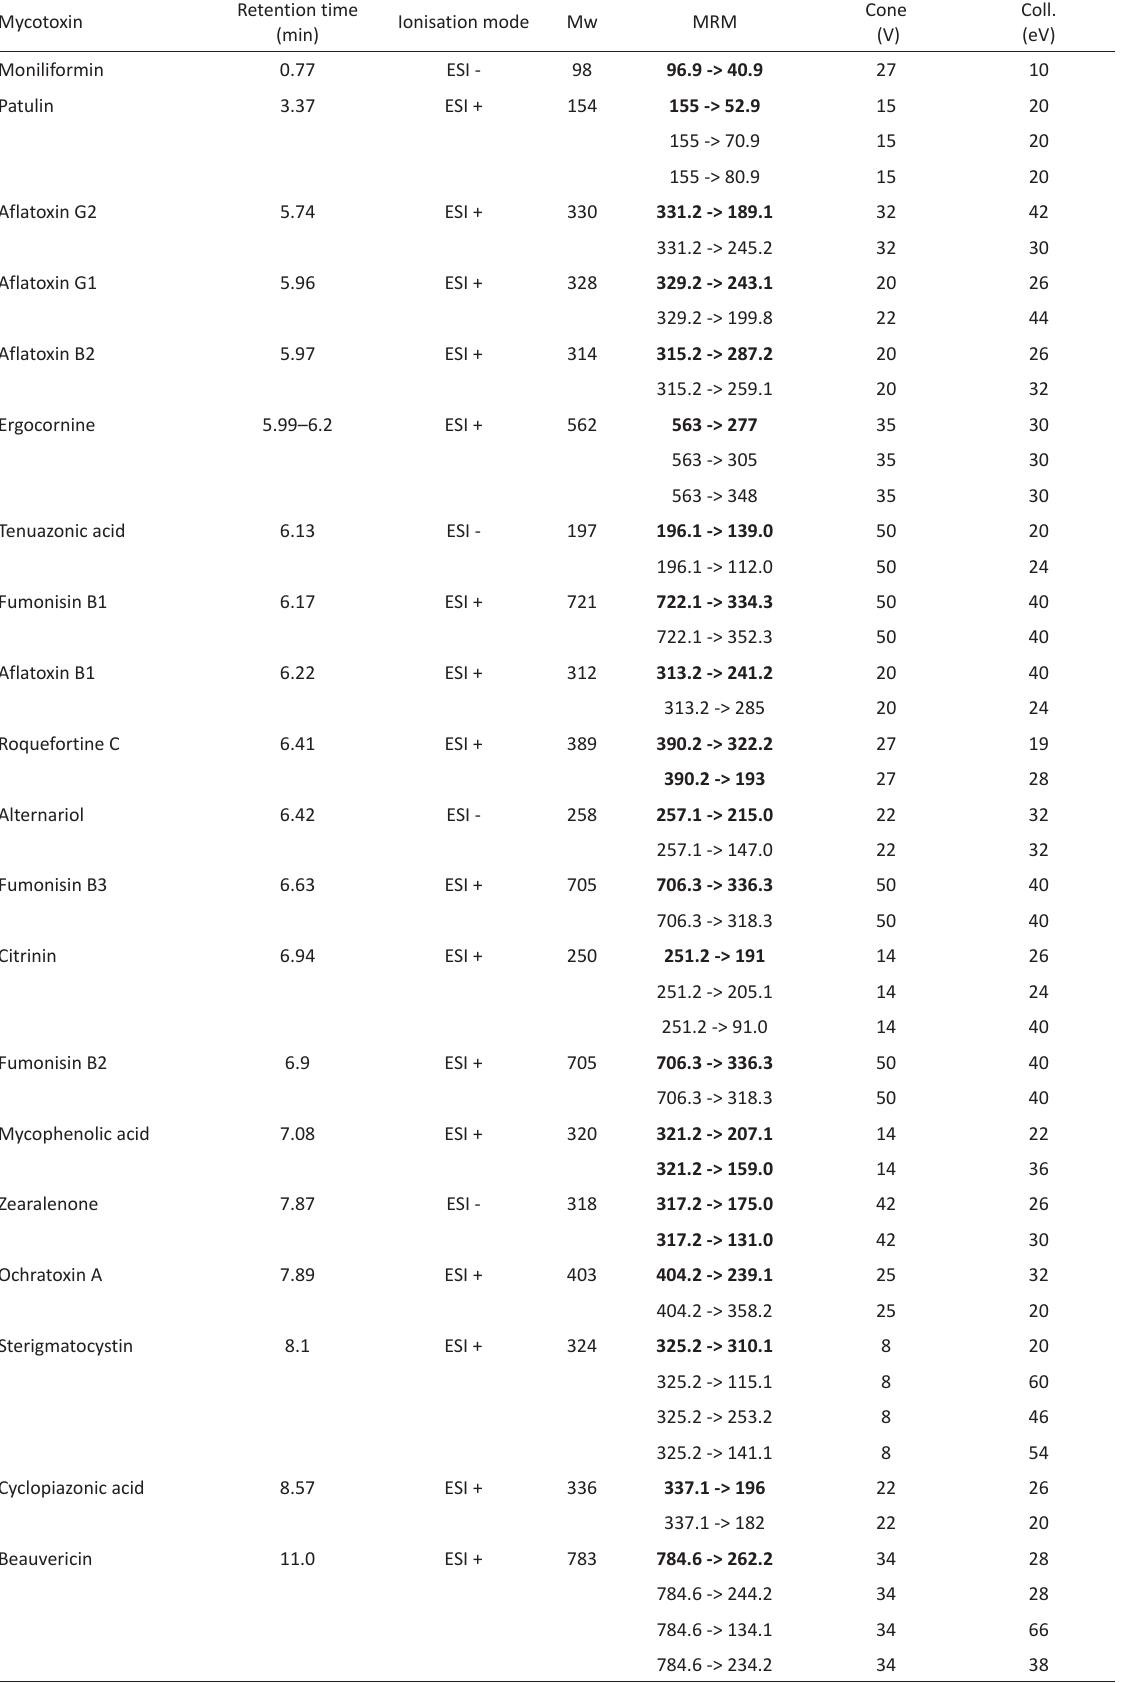
Table 2. Retention times, ionisation modes, molecular weights (Mw), multiple reaction monitoring settings (MRM), cone voltages (Cone) and collision energies (Coll.) for mycotoxins determined with UPLC-MS/MS. Bold MRMs were used for identification, other as